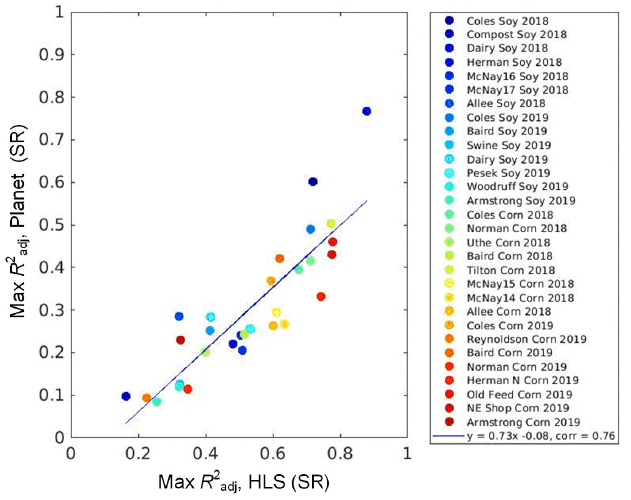
Figure 11. Comparison of R 2 for best models between corn and soybean yields and SR values obtained with HLS and Planet data.